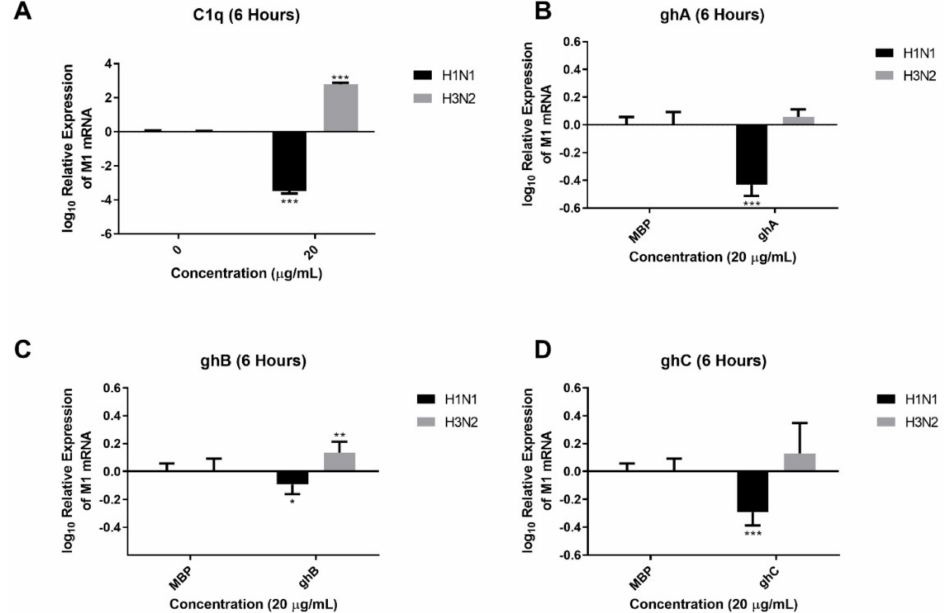
Figure 3. IAV pre–treatment with human C1q ( A ), ghA ( B ), ghB ( C ) or ghC ( D ) suppresses replication of H1N1-infected A549 cells while upregulating replication in H3N2. mRNA transcript levels of M1 expression of H1N1 and H3N2 IAV subtypes (IAV) (MOI 1) 6 h post-infection in A549 cells were measured. A549 cells were incubated with H1N1 or H3N2, pre–treated with or without human C1q or its recombinant globular head modules (20 µ g/mL). Following cell lysis, RNA was extracted and converted into cDNA. M1 expression levels were measured via qRT–PCR using M1 primers to assess IAV replication; 18S was used as an endogenous control. Data are shown as the normalized mean of three independent experiments performed in triplicate ± SEM. C1q ( A ) was normalized to M1 levels of its control (cells + virus only), and the globular heads ( B – D ) were normalized to M1 levels of their control (Cells+ virus pre–treated with 20 µ g/mL of MBP). Significance was determined using the two–way ANOVA test (* p < 0.05, ** p < 0.01, *** p < 0.001, ( n =